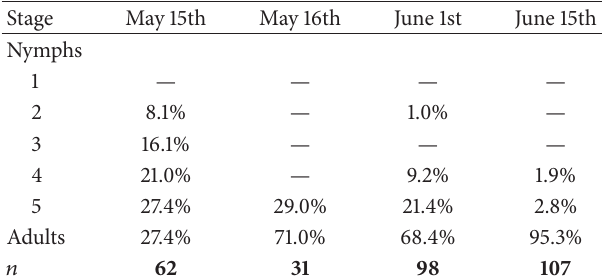
Table 1: Distribution of nymphal and adult stages in G. pallens collections tested for their tendency to eat M. sexta eggs (Figure